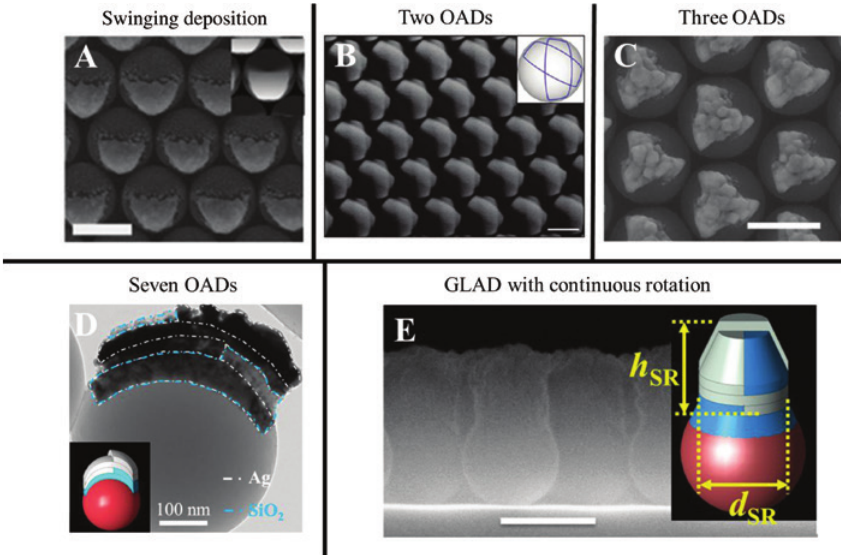
Figure 7: Patchy particles fabricated by multiple deposition. (A) SEM image of the Ag deposited on PS bead monolayers by swinging deposition with sweep angles ( ∆ ϕ = 60 ° ) and initial domain = 30 ° ) [47]. (B) SEM image of the patchy particles fabricated by two subsequent OADs [48]. The inset shows the orientations ( ϕ 0